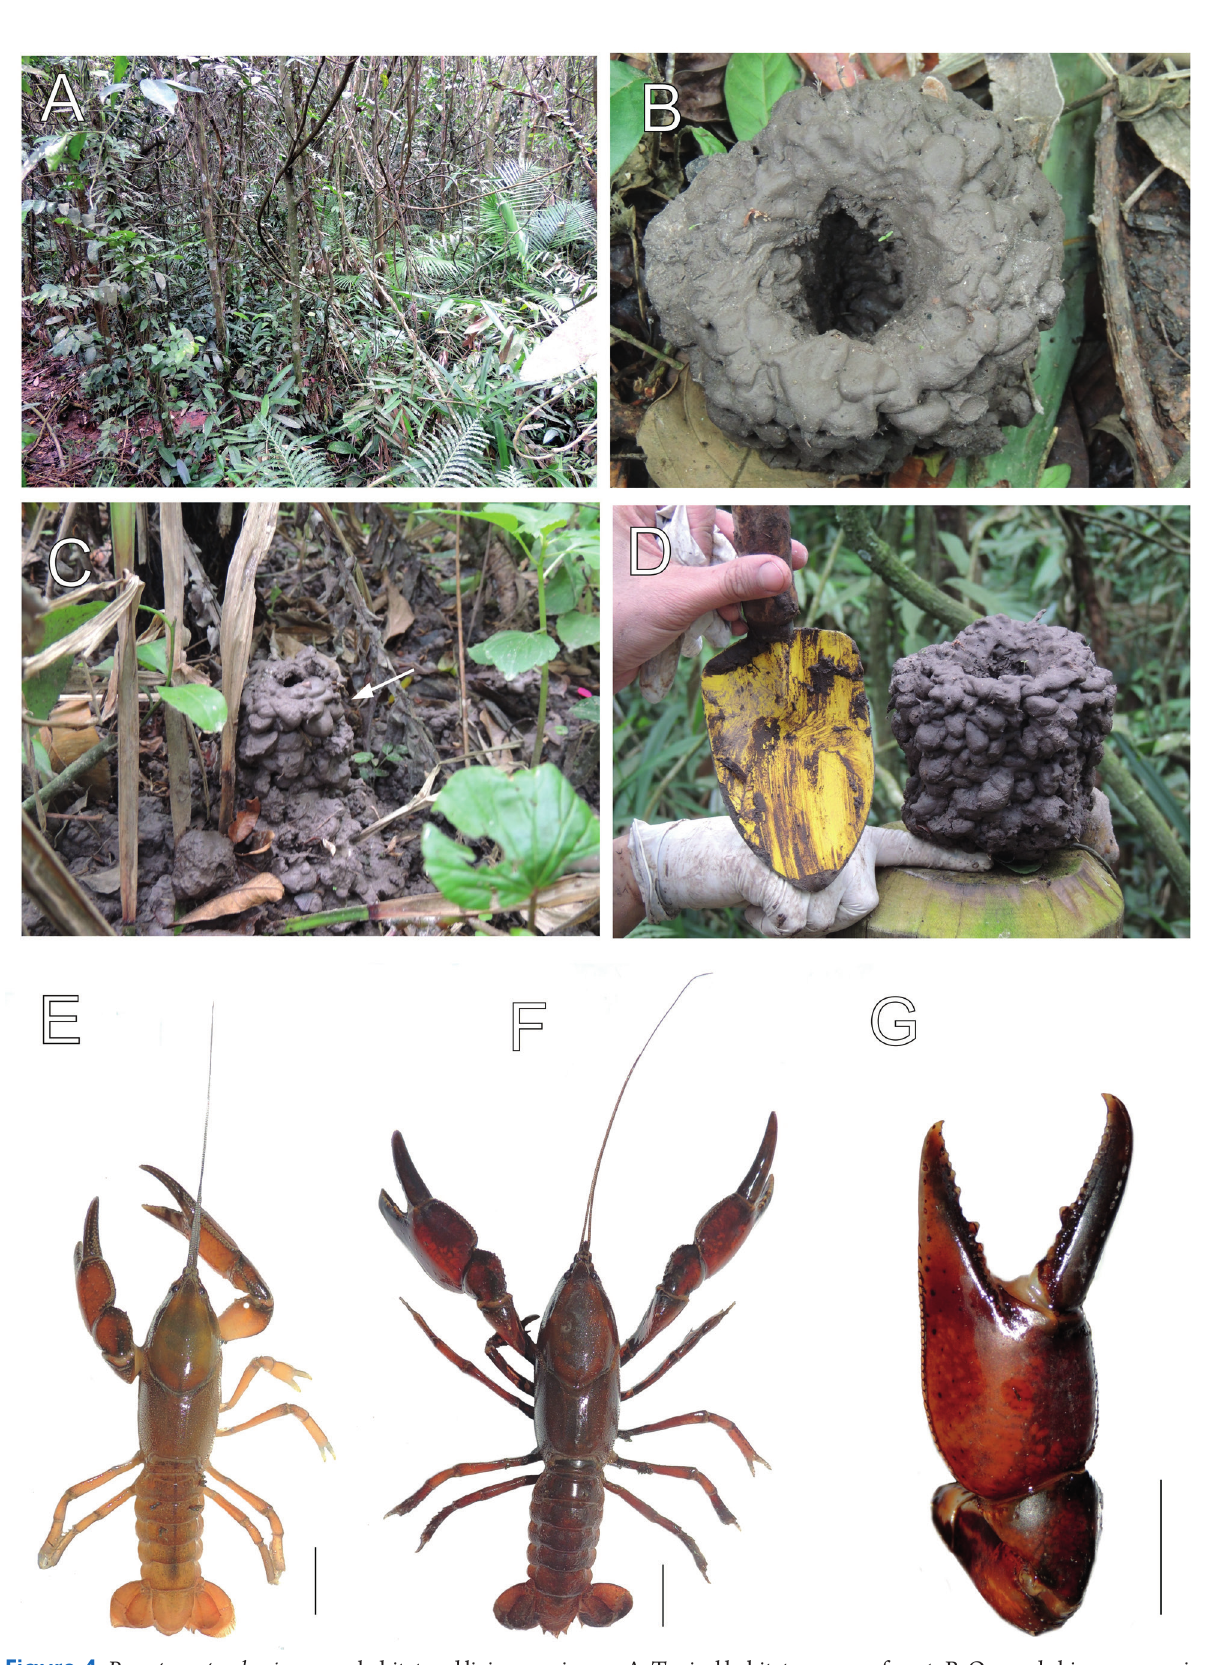
Figure 4. Parastacus tuerkayi sp. nov., habitat and living specimens. A, Typical habitat, a swamp forest; B, Opened chimney superior view; C and D, opened chimney lateral view, white arrow indicates the chimney; E and F, living specimens, habitus dorsal view UFRGS 6438 and holotype, respectively); G, living specimen (holotype), cheliped lateral view. Scale bars: E, F, G = 10